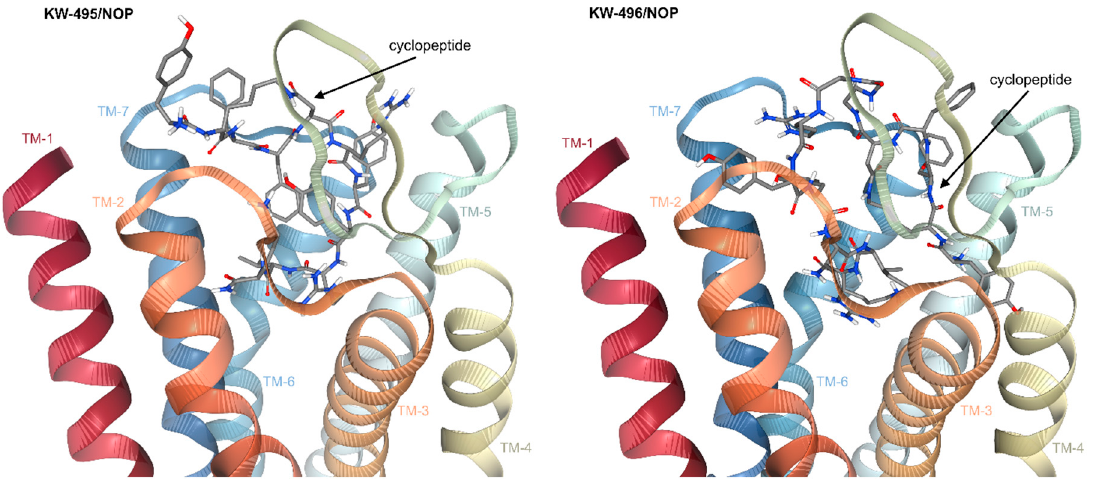
Figure 6. Side views of the predicted complexes of KW-495 /NOP and KW-496 /NOP obtained with the receptor models extracted from PDB ID 5DHG. The ligands are rendered in thick lines; C is rendered in gray, N in blue and O in red. Figure obtained with PacDOCK web server [56,57].